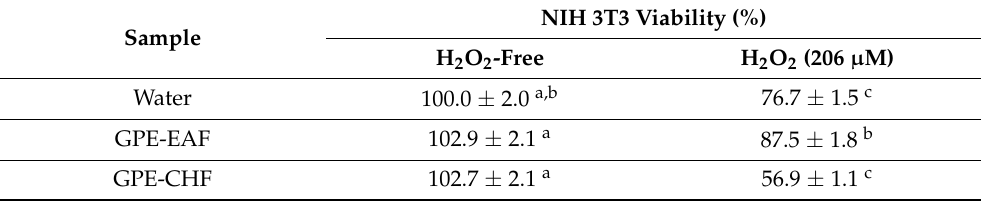
Table 2. Effect of ethyl acetate (GPE-EAF) and the chloroform (GPE-CHF) fractions on viability of NIH 3T3 cells in the absence (normal condition) and presence (hostile conditions) of H 2 O 2 . Sample